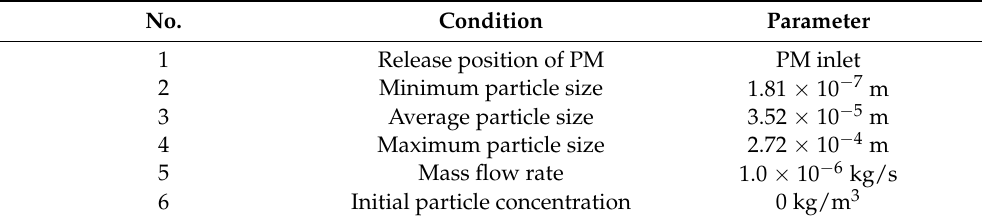
Table 1. Parameter setting of PM.